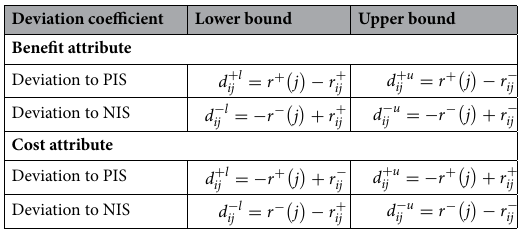
Table 1. Deviation coefficient of the attribute j